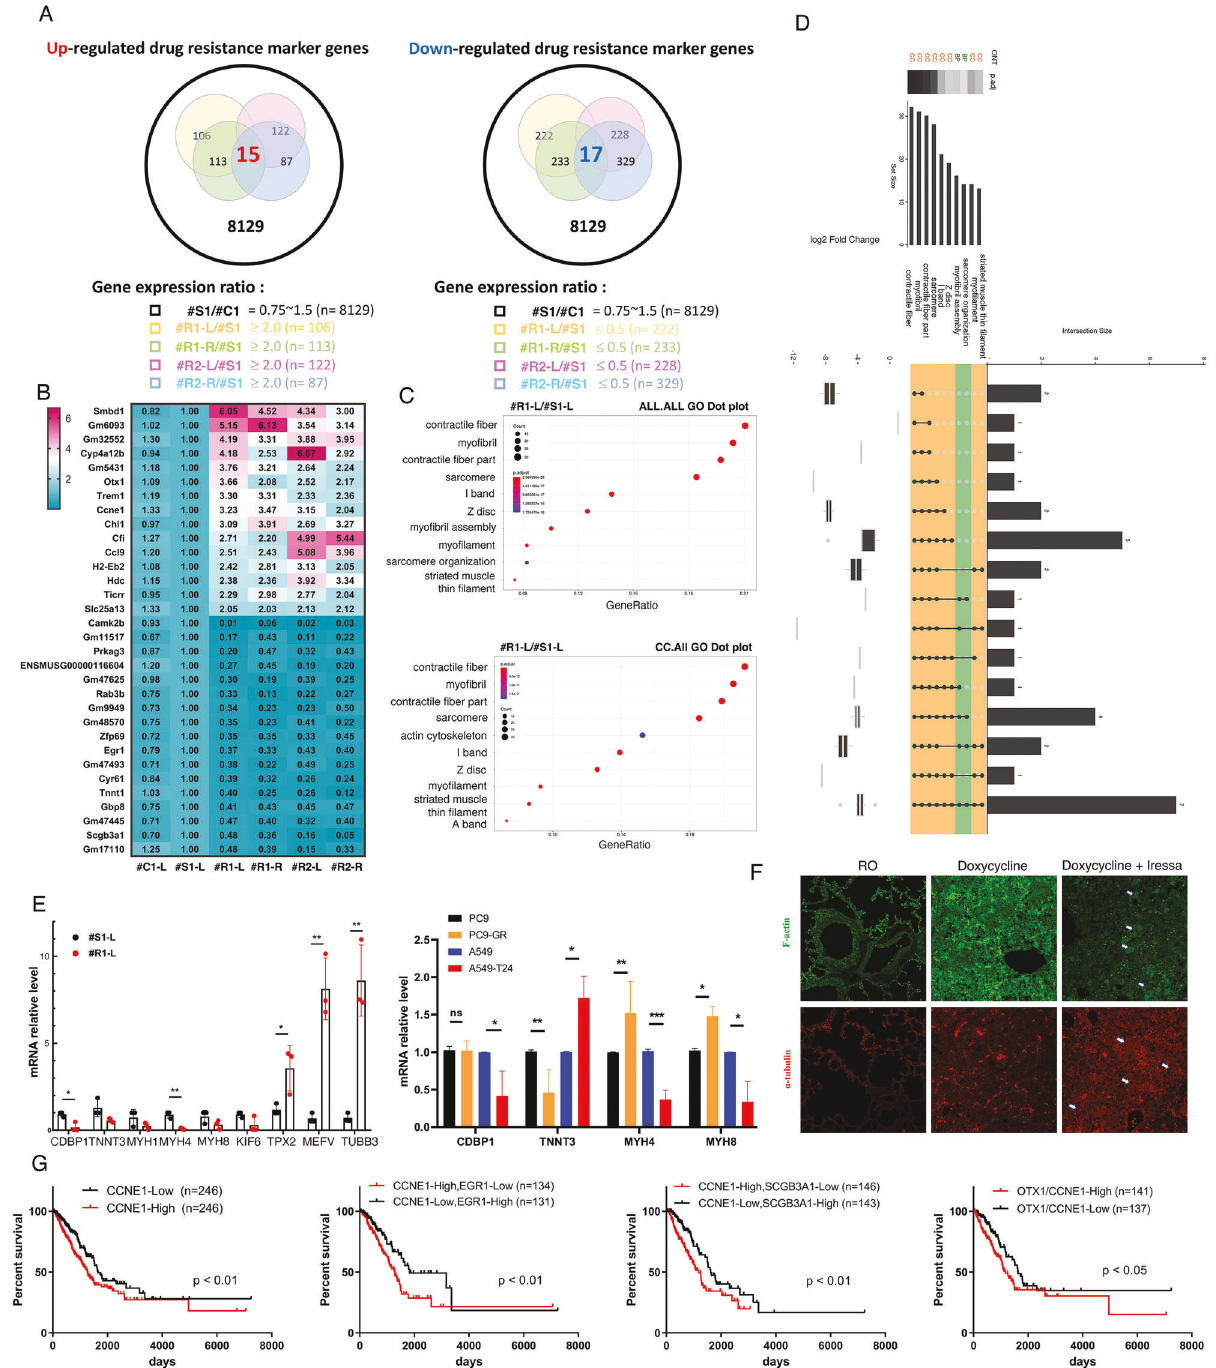
Fig. 7 Genes were regulated during drug resistance acquisition but not during tumorigenesis in mice with TKI-induced drug resistance. RNA samples isolated from normal ( n = 1; #C1), drug-sensitive ( n = 1; #S1) and drug-resistant (n = 2; #R1-L, #R1-R, #R2-L and #R2-R) mice were used to study the gene expression by RNA-seq. Up- and downregulated genes in drug-resistant mice were studied by identifying the overlapping genes between drug-sensitive and drug-resistant mice ( A ). Gene expression during drug resistance acquisition was studied by RNA-seq and is shown here on a heatmap ( B ). The signi fi cance of the GO terms regulated by drug resistance was studied by generating ALL and CC GO dot plots ( C ) and a GO Upset plot ( D ). All genes showing change only in mice with drug resistance by RNA-seq were used for validation by qPCR with more samples from drug-resistant mice and various drug-resistant cell lines, PC9, Ge fi tinib-induced drug-resistant PC9 (PC9-GR), A549 and Taxol-induced drug-resistant A549 (A549-T24). The statistical assay was performed by t test after three independent experiments; * p < 0.05, ** p < 0.01, *** p < 0.005, ns: non-signi fi cance ( E ). The signals of F-actin (green) and α -tubulin (red) in the lungs of drug- sensitive and drug-resistant mice with lung cancer were studied by IF with anti-actin and anti-tubulin antibodies ( F ). The relationships between the survival rates in lung cancer cohorts from TCGA and the levels of several genes ( CCNE1, CCNE1/EGR1, CCNE1/SCGB3A1 and OTX1/ CCNE1 ) in the lungs of drug-resistant mice ( G ).